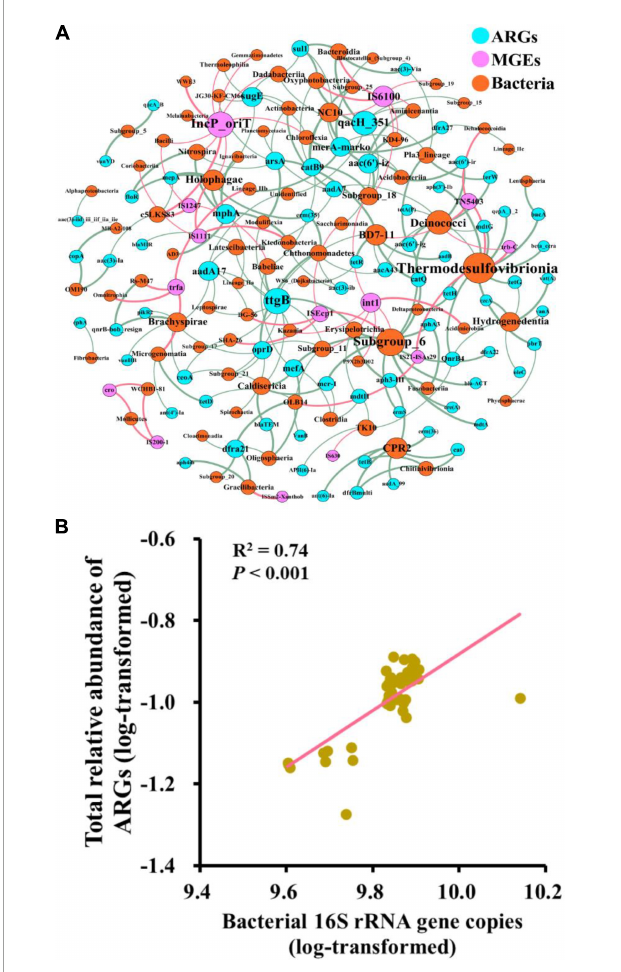
FIGURE5 The network of co-occurrence patterns among ARGs, MGEs, and bacterial taxa at the class level (A) and the correlation between 16S rRNA gene copies and the relative abundance of total ARGs (B)